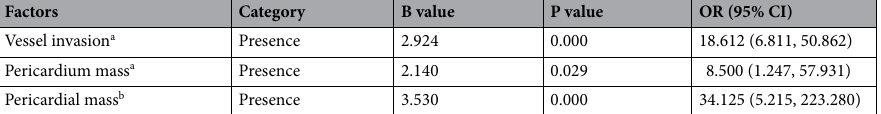
Table 3. Independent predictors by logistical regression analysis. a Thymic carcinoma; b high-risk thymoma.